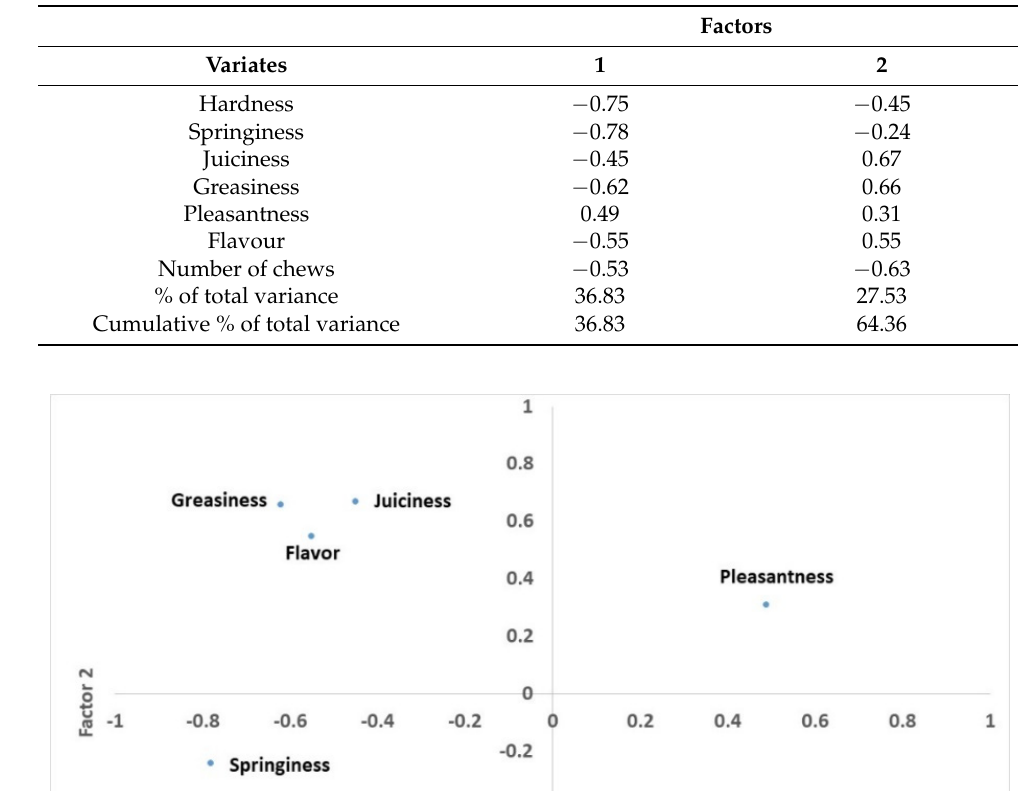
Table 3. PCA (principal components analysis) results for the first two principal components of sensory parameters in Rubia de El Molar suckling lambs’ meat.